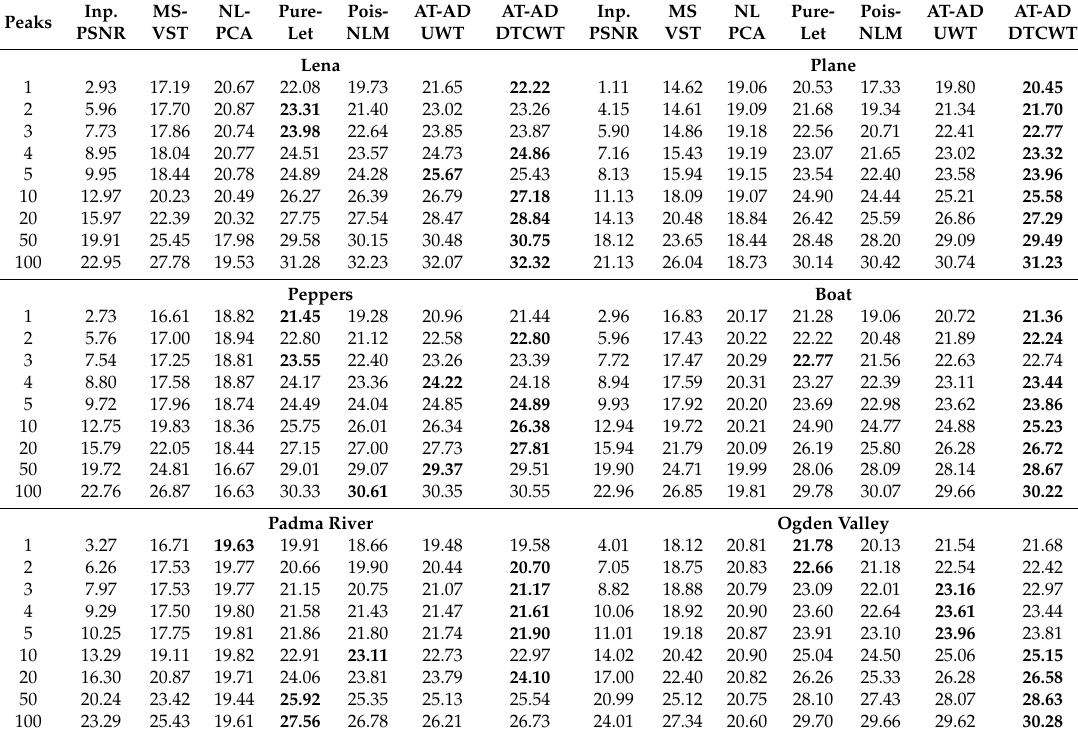
Poisson denoising: Output PSNR value obtained from the proposed method and state-of-the-art comparative methods for input images at varying input PSNR levels (bold denotes highest PSNR). Peaks